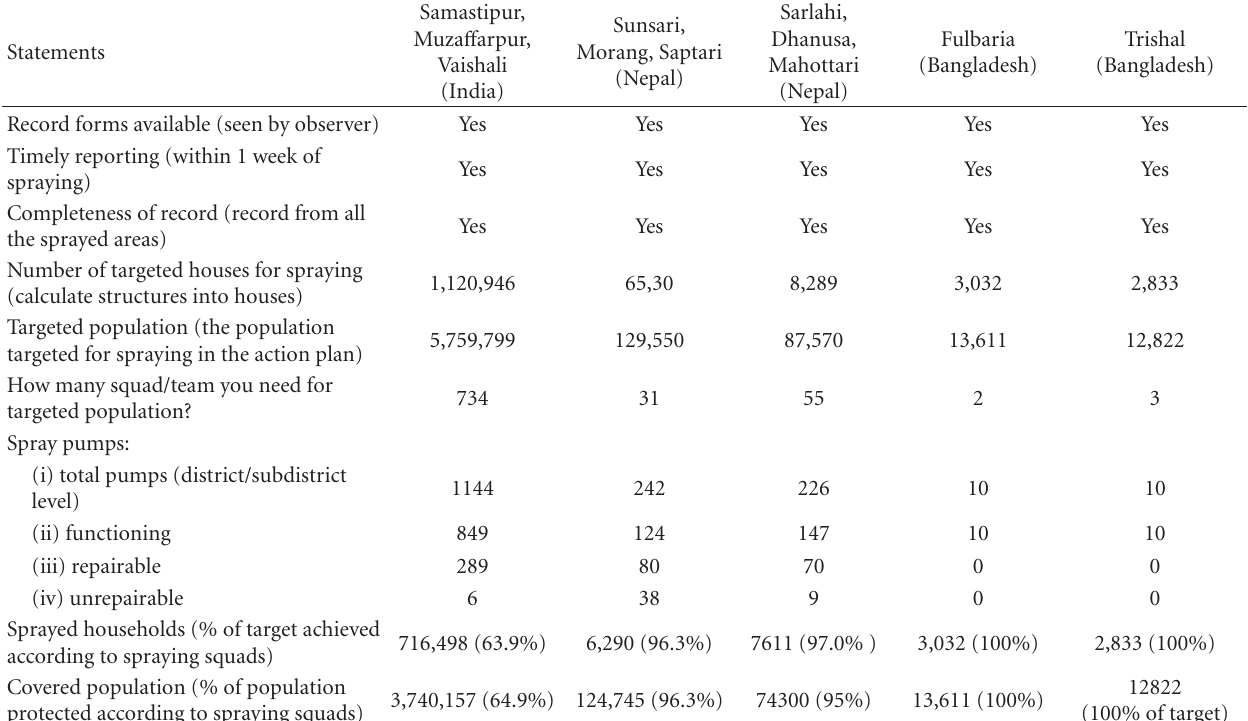
Table 3: Findings of output indicators: review of documents of spraying programme at district/subdistrict after